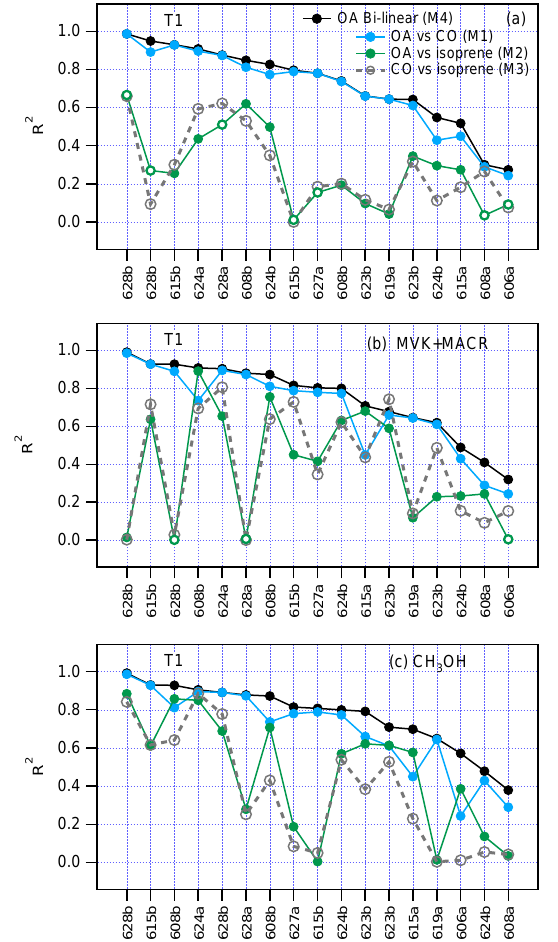
Figure 3. Coefficient of determination ( R 2 ) for transects on Leg T1, using CO as an anthropogenic tracer and (a) isoprene, (b) MVK + MACR, and (c) CH 3 OH as a biogenic tracer. Results rank ordered according to R 2 of bilinear model, M4-Bio. Open green circles indicates transects in which OA is anti-correlated with Bio. Legend in panel (a) identifies regression models.